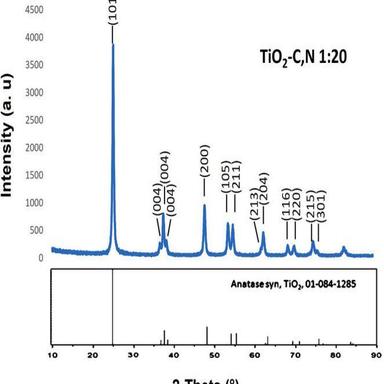
XRD diffraction pattern of the TiO2–C,N powder photocatalyst. Fig. 3. Band gap of TiO2–C,N obtained by DRUV-Vis.